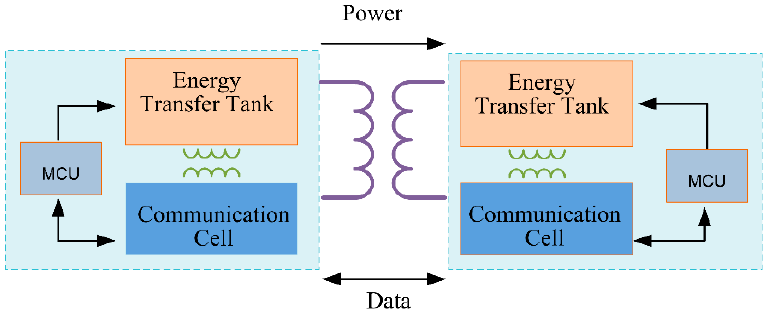
Figure 1. The structure of an simultaneous wireless transmission of power and information (SWTPI) setup.